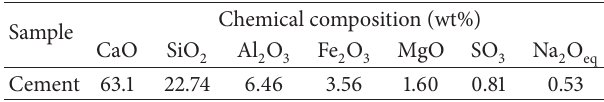
Table 1: Chemical composition of the cement used for determining alkali reactivity of